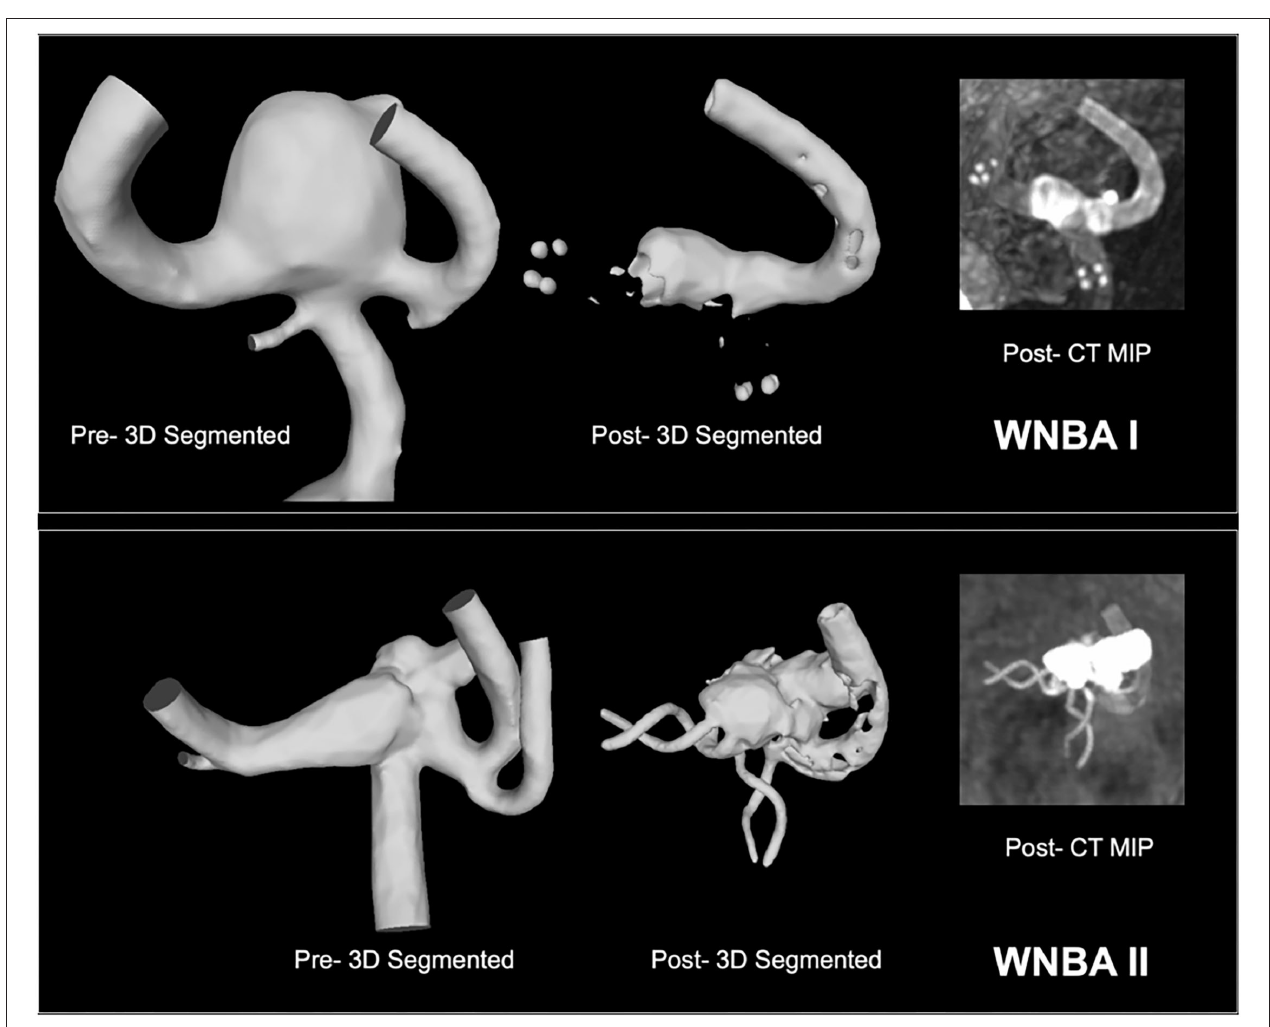
FIGURE 1 | WNBA geometries I and II reconstructed from CT angiography pre-intervention with Flow-T for virtual stenting (left) and post-intervention for reference (right). Flow diverters placed in the secondary daughter vessel (right-hand in both orientations) are fully visible while the stent placed in the primary daughter vessel is indicated with end (LVIS EVO) or helical (Baby Leo)